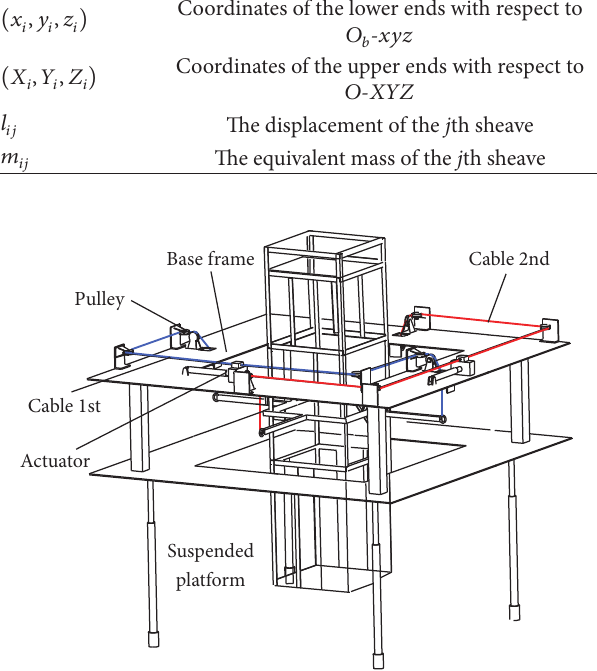
Figure 1: 3D model of